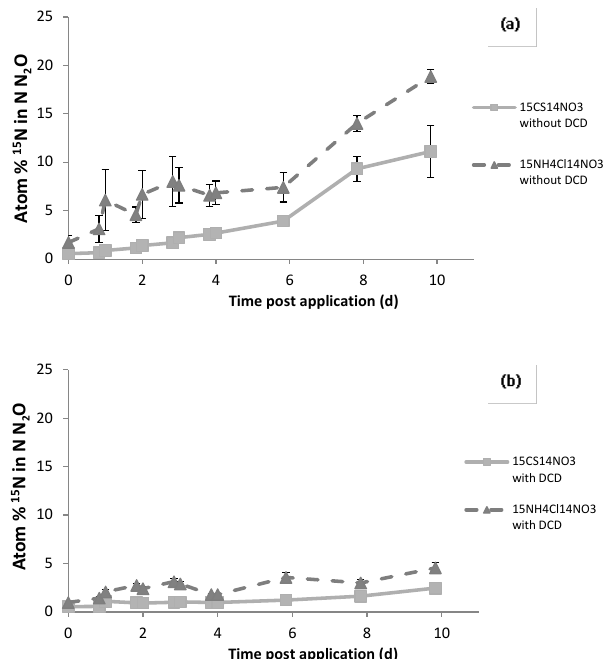
Fig. 5. Change in atom % 15 N in N 2 O over time in March 2009 for 15 CS 14 NO 15 NH 14 NO 3 and 4 Cl 3 without DCD (a) and with DCD Figure 5. Change in atom % 15 N in N 2 O over time in March 2009 for 15 CS 14 NO 3 and 670 (b) . Error bars indicate standard 15 NH 14 NO 4 Cl 3 without DCD (a) and with DCD (b). 671